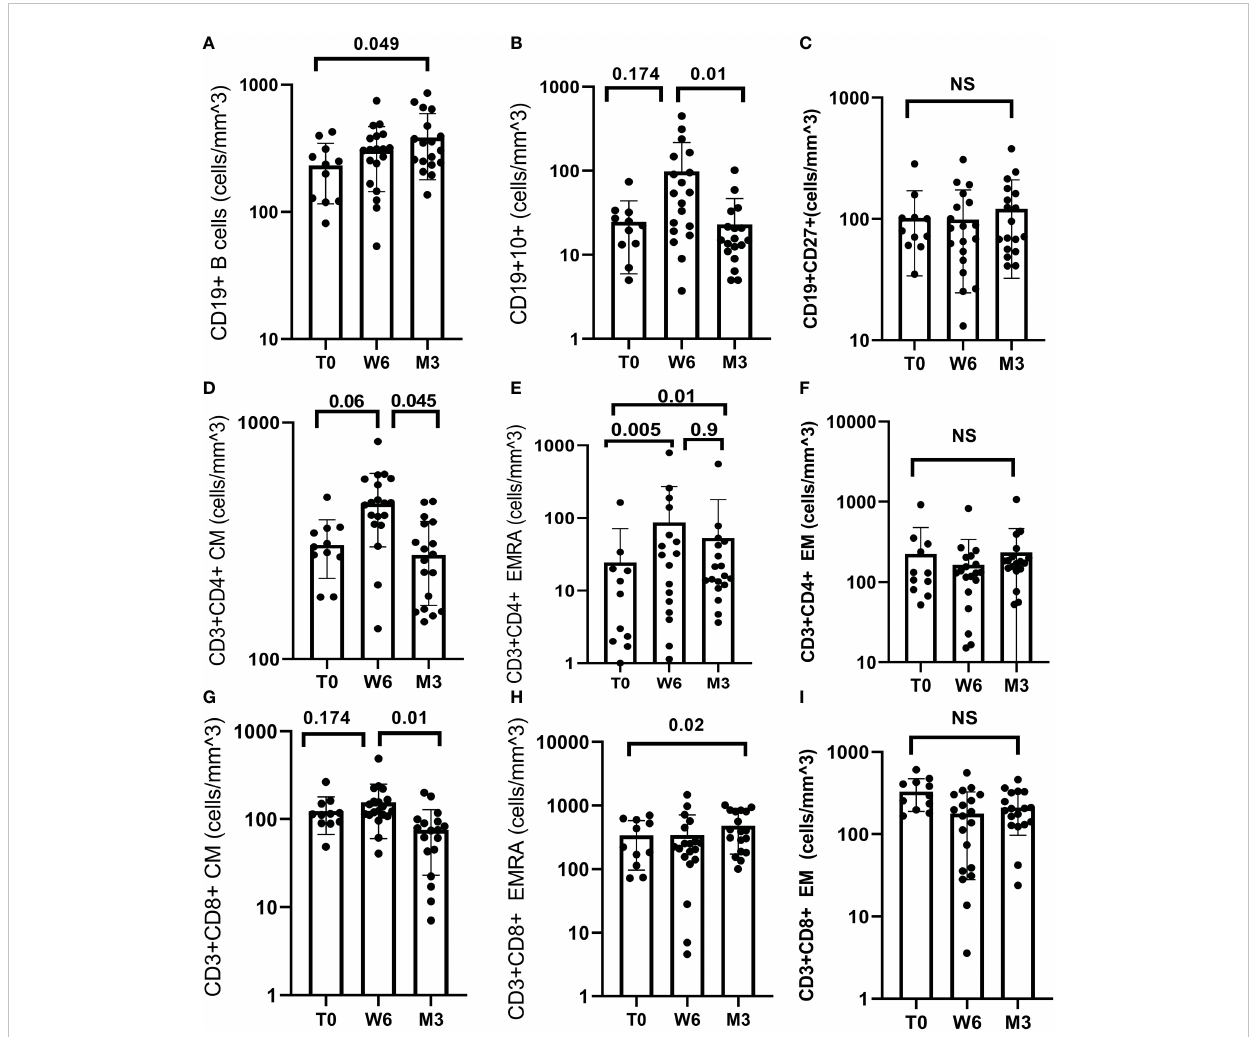
FIGURE 2 B and T cell response after BNT162b2 vaccine. (A) Median CD19+ was 243.39 at T0 (IQR 160.61), 312.59 (IQR 93.81) at W6 and 330.27 (IQR 360.62) at M3. CD19+ increased signi fi cantly between T0 and M3 (p = 0.049). (B) Median CD19+CD10+ was 23.64 (IQR 15.85) at T0, 44.19 (IQR 196.94) at W6 and 14.97 (IQR 8.07) at M3. CD19+CD10+ increased at W6 (p = 0.174) and decreased at M3 (p=0.01). (C) Median CD19+CD27+ was 76.0 (IQR 39.53) at T0, 94.74 (IQR 61.5) at W6 and 107.3 (IQR 120.69) at M3, (p = 0.741). (D) Median CD3+CD4+CM was 303 (IQR 80) at T0, 431 (IQR 144) at W6 and 285 (IQR 130) at M3. CD3+CD4+CM increased from T0 to W6 (p=0.06) and decreased between W6 and M3 (p=0.045). (E) Median CD3 +CD4+EMRA was 8.27 (IQR 17.62) T0, 36.71 (IQR 142.05) at W6 and 19.0 (IQR 25.81) at M3. CD3+CD4+ EMRA increased from T0 to W6 (p = 0.005), and from T0 to M3 (p=0.01) but decreased from W6 and M3 (p=0.9). (F) Median CD3+CD4+EM did not change over time (p = 0.301). (G) Median CD3+CD8+CM was 112.97 (IQR 26.1) at T0, 143.66 (IQR 89.2) at W6 and 80.9 (IQR 47.77) at M3. CD3+CD8+CM decreased between W6 and M3 (p=0.01). (H) Median CD3+CD8+EMRA was 327.68 (IQR 406.18) at T0, 237.18 (IQR 64.03) W6 and 435.1 (IQR 546.17) M3. CD3+CD8+ EMRA increased between T0 and M3 (p = 0.02). (I) CD3+CD8+ EM cell did not change over time, (p = 0.235). Test: Wilcoxon Mann-Whitney